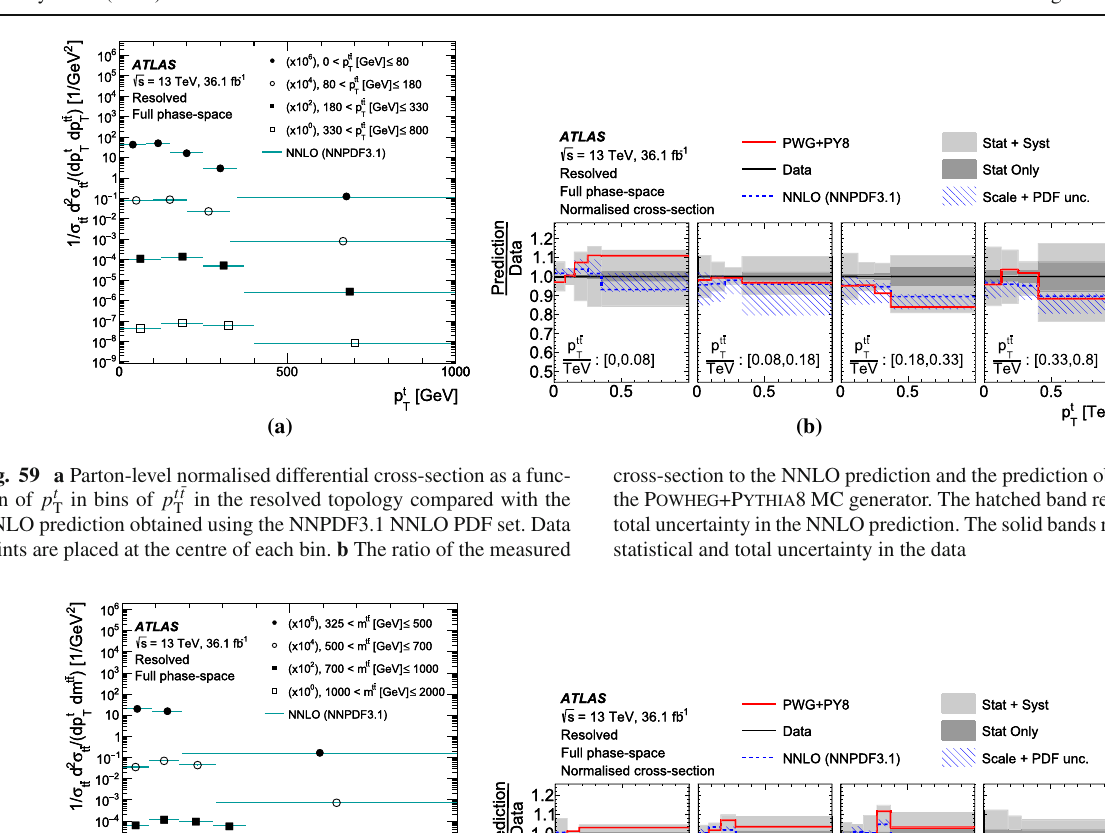
cross-section to the NNLO prediction and the prediction obtained with the Powheg + Pythia8 MC generator. The hatched band represents the total uncertainty in the NNLO prediction. The solid bands represent the statistical and total uncertainty in the data